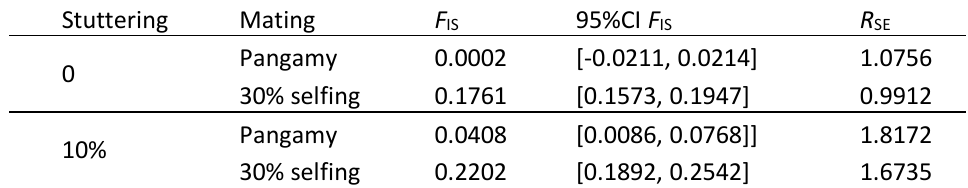
Table 1: Results obtained for F IS , its 95% confidence interval (95%CI, 5000 bootstraps over loci) and for the ratio of jackknife over loci standard error between F IS and F ST ( R SE ), for 0 or 10% of stuttering and for pangamic dioecious populations or monoecious populations with 30% selfing.